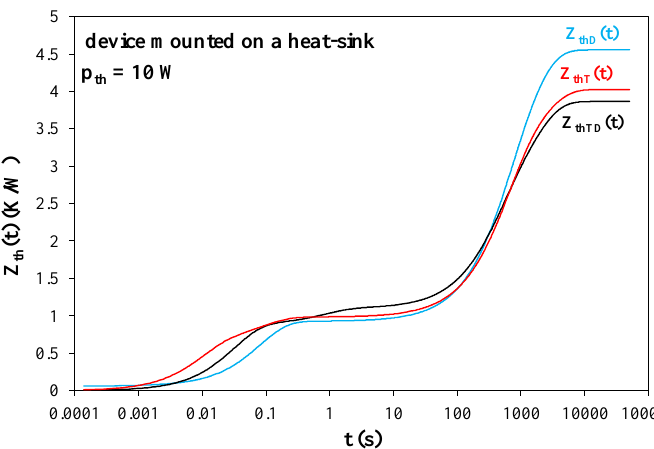
Figure 9. Measured waveforms of self and transfer transient thermal impedances in the investigated device situated on the heat-sink.